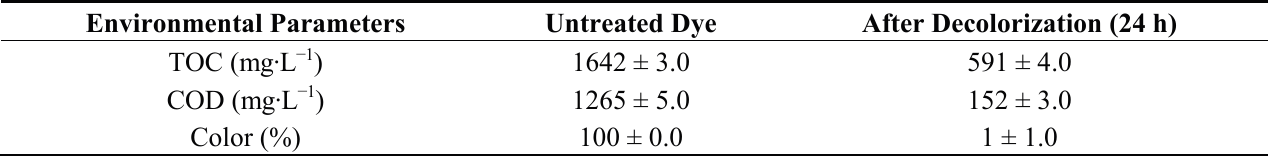
Table 2. Environmental parameters of the untreated dye Trypan Blue (50 mg·L − 1 ) and after treatment with microbial